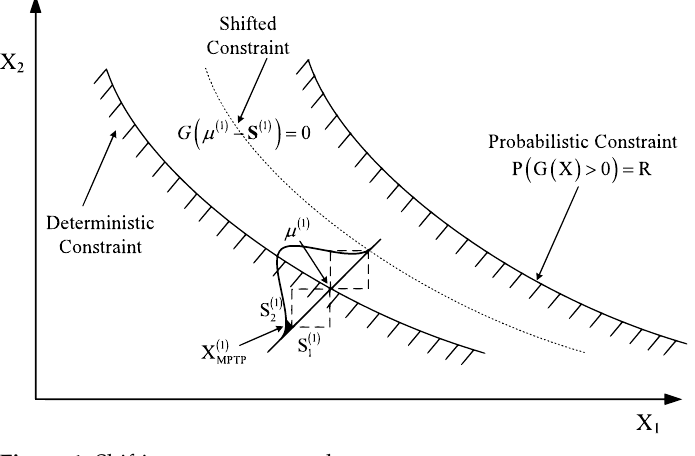
Figure 1. Shifting vector